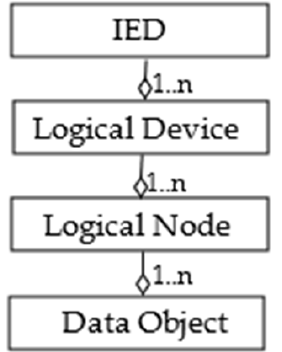
Figure 1. IEC 61850 Data Model.